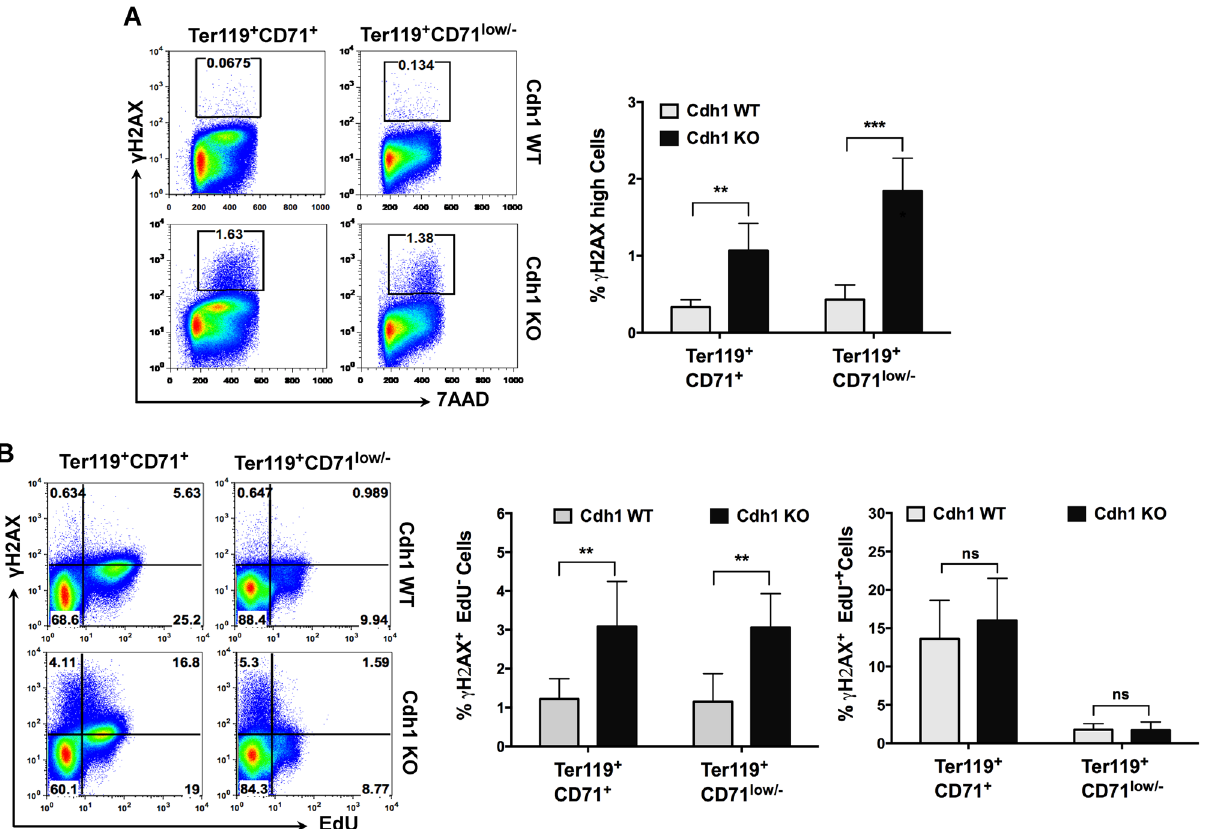
Figure 6. Accumulation of DNA damage in Cdh1-deficient maturing erythroblasts. Fetal liver cells from control (Cdh1-WT) and Cdh1-null (Cdh1-KO) E17.5 embryos were sorted based on Ter119 and CD71 expression and then stained for EdU, ɣ H2AX and DNA content (n = 4 for each genotype). ( A ) Quantitation of cells with strong ɣ H2AX staining in the indicated sorted erythroblast populations. Left panels show representative flow cytometry plots and include the gate used for quantitation (black box). ( B ) Within each of the sorted erythroblast populations, the percentage of cells positive for ɣ H2AX and EdU (right column graph) or positive for ɣ H2AX but negative for EdU (left column graph) was measured. The representative flow cytometry plots (left panels) show the corresponding gating. ** P < 0.01, *** P < 0.001, ns (not significant) P >